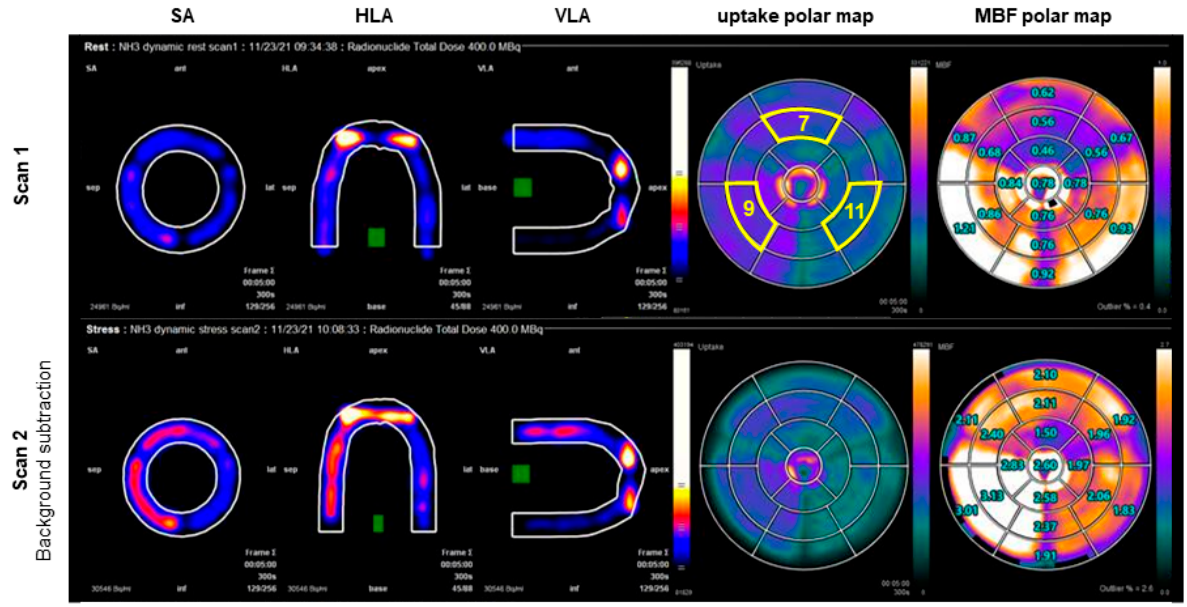
Figure 4. Two PET-CT myocardial perfusion imaging scans. The cross-sections along the sagittal axis (SA), horizontal longitudinal axis (HLA) and vertical longitudinal axis (VLA) display accumulated radiotracer activity. The green boxes indicate the regions of interest that were used to calculate the arterial input function. The polar plots show myocardial tracer uptake (left) and computed myocardial blood flow (MBF) (right). The three depicted heart segments (circled in yellow in the top uptake polar map) represent the center of the three phantom tissue regions (myo1 ‒ 3) and were used for further tissue response function and MBF analysis.